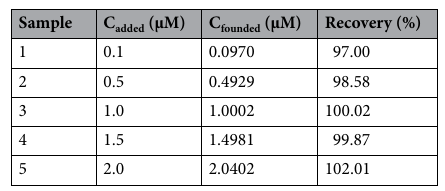
Table 3. Determination of H 2 O 2 in milk sample